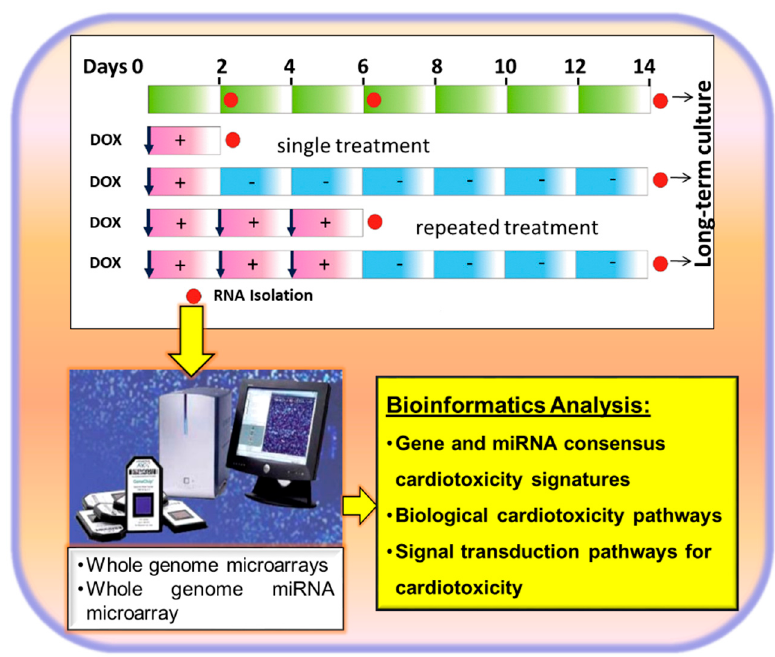
Figure 2. Combination of a repeated toxicity treatment protocol with transcriptomics to identify genomics biomarkers and cardiotoxicity pathways for doxorubicin.